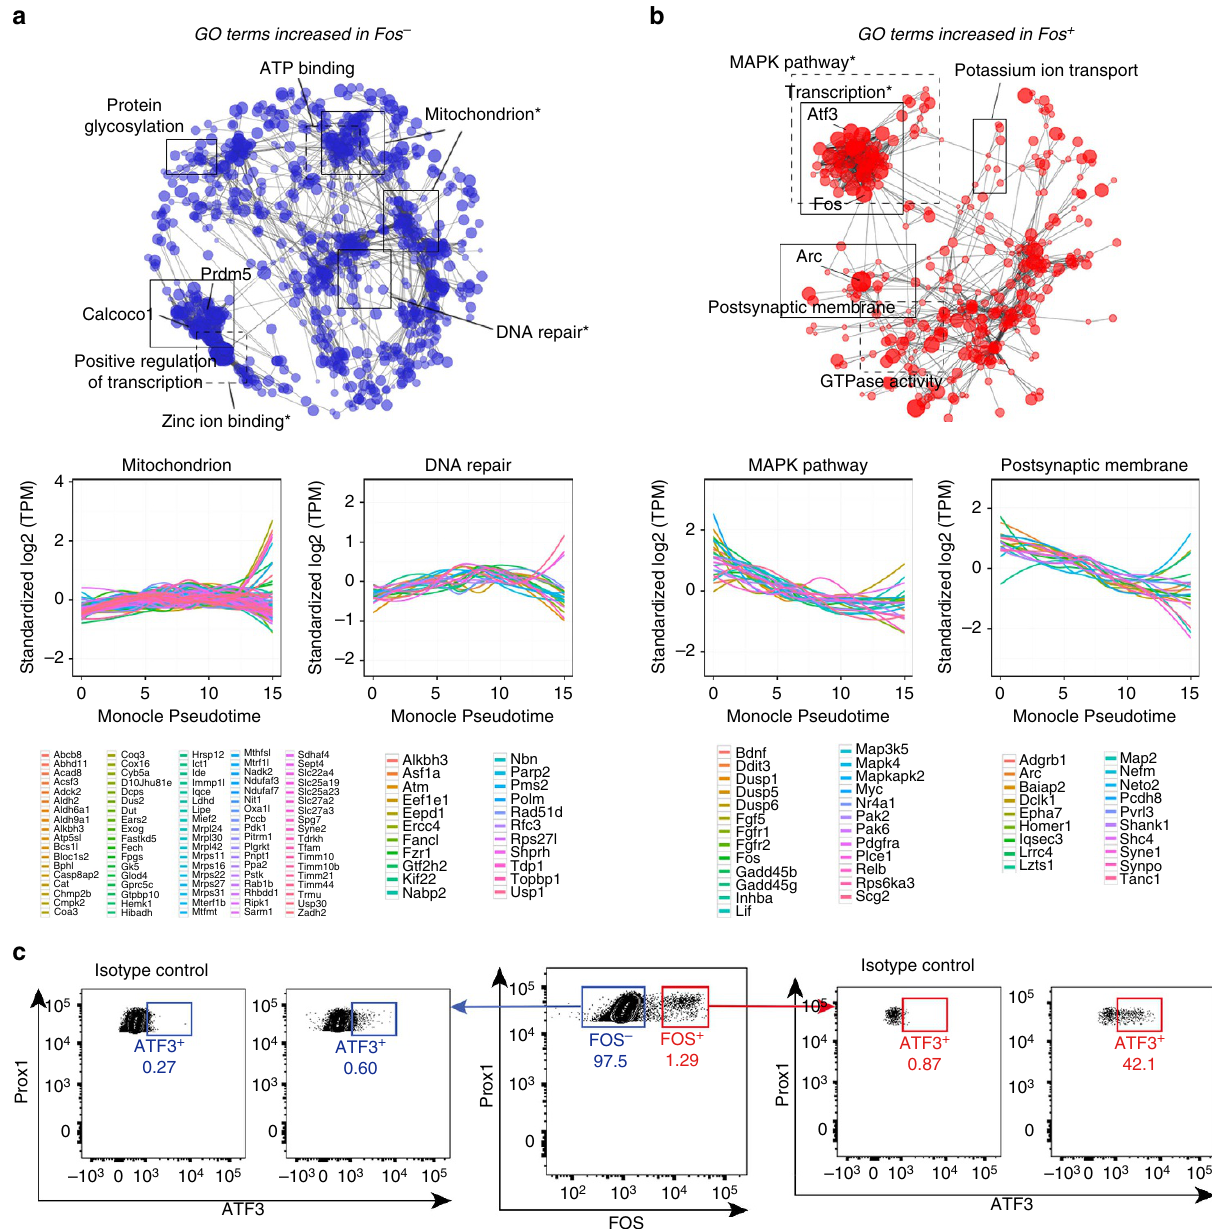
Figure 4 | Gene ontology for FOS (cid:2) and FOS þ nuclei. Clustering based on Gene Ontology terms for differentially expressed genes either higher in FOS (cid:2) nuclei ( a ) or FOS þ nuclei ( b ). Two categories are plotted below as a function of pseudotime using Monocle. ( c ) Representative FACS plots showing expression of ATF3 þ in single-nuclei isolated from the hippocampus of a wild-type mouse exposed 15min to an NE and killed 1h later. Right panel shows expression of ATF protein in PROX1 þ FOS þ nuclei and the left panel shows ATF in PROX1 þ FOS (cid:2) nuclei. 42.1% of PROX1 þ FOS þ nuclei co-express ATF3 as indicated by the red gate. Asterisks indicate significant functional enrichment after multiple-testing correction using